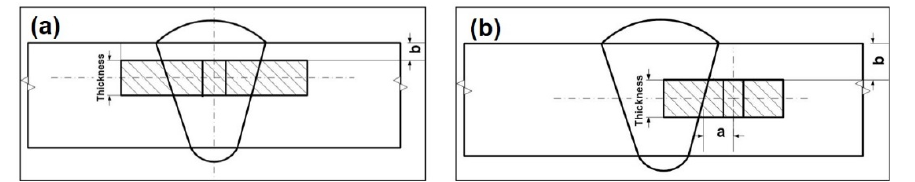
Figure 10. Charpy V-notch impact test specimen sizes per EN ISO 9016:2011. ( a ) VWT; V-notch in fusion zone; ( b ) VHT; V-notch in HAZ (all dimensions in mm).